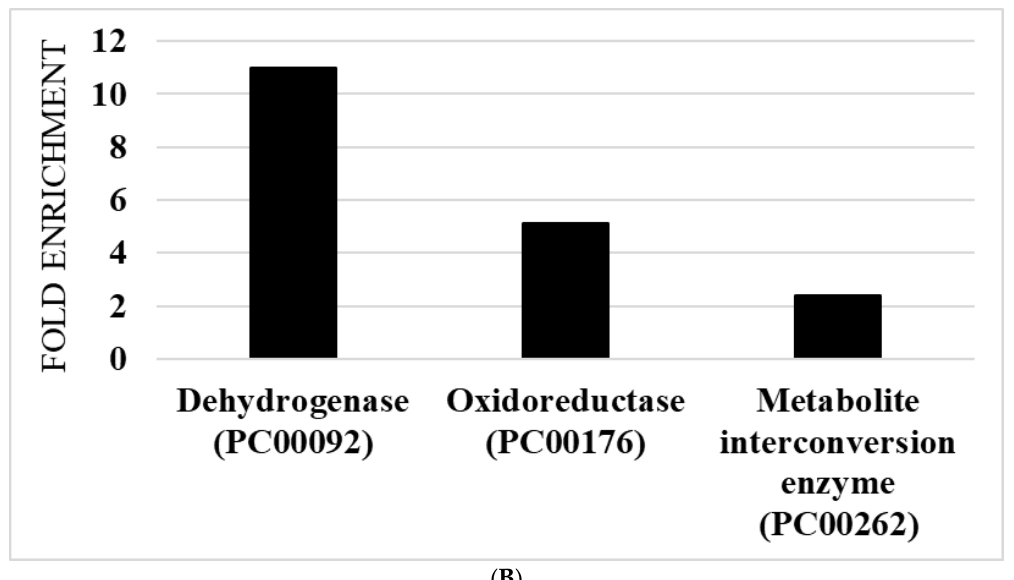
Figure 4. Comparison between transcriptomics of AFAT and redoxomics of acute AF trophozoites. ( A ) PANTHER sequence classification of genes upregulated in AFAT that have their product oxidized in acute AF trophozoites. ( B ) PANTHER statistical overrepresentation test of upregulated genes in AFAT that have their product oxidized in acute AF trophozoites.